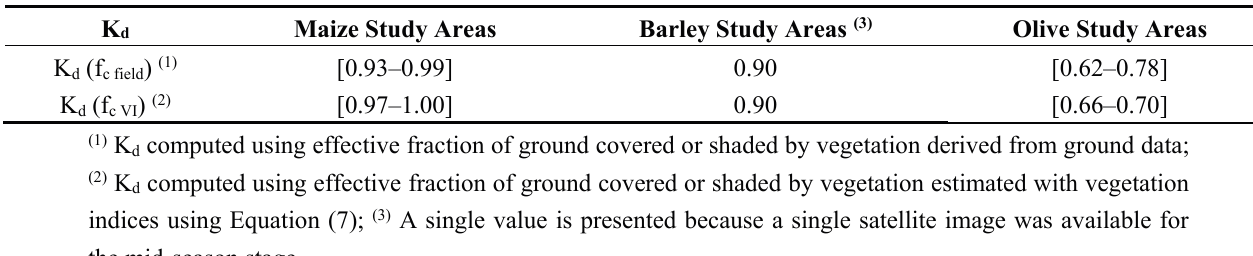
Table 3. Range of values of density coefficient computed for the satellite image dates of the mid-season stage in the three